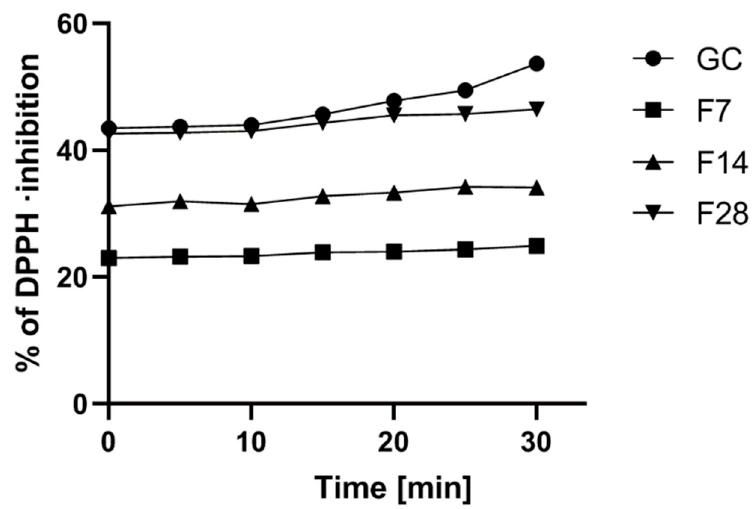
Figure 2. Kinetics of the absorbance changes in DPPH solutions of green coffee beans’ extract and kombucha ferments. Values are mean of three replicate determinations ( n = 3).